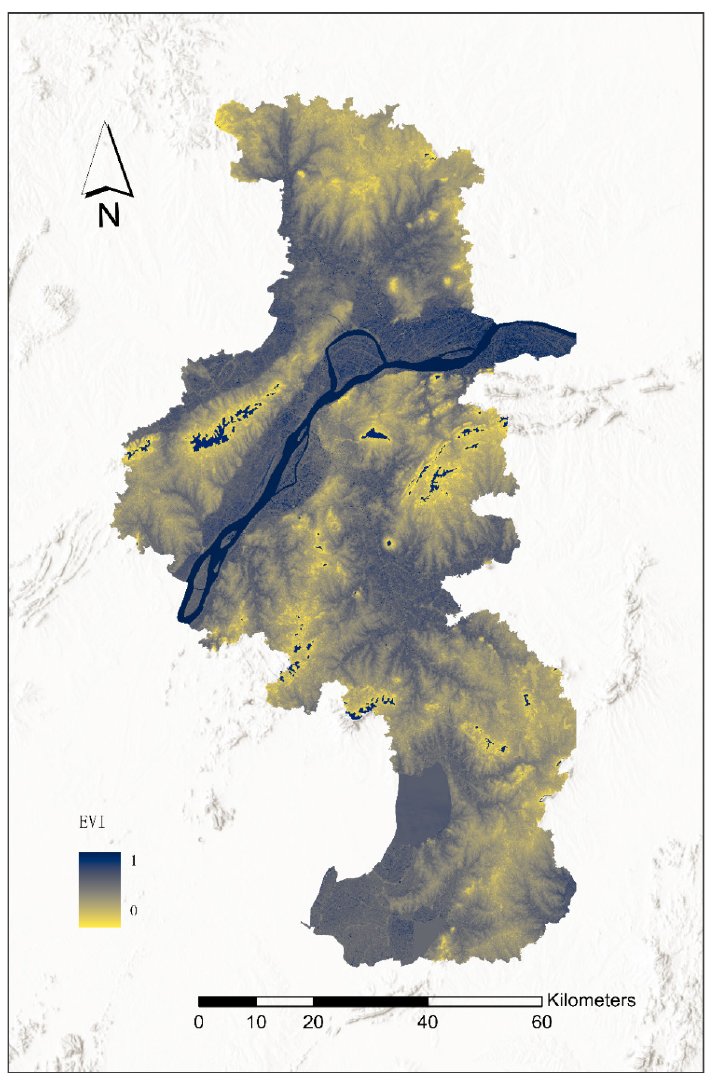
Figure 3. Urban EVI in